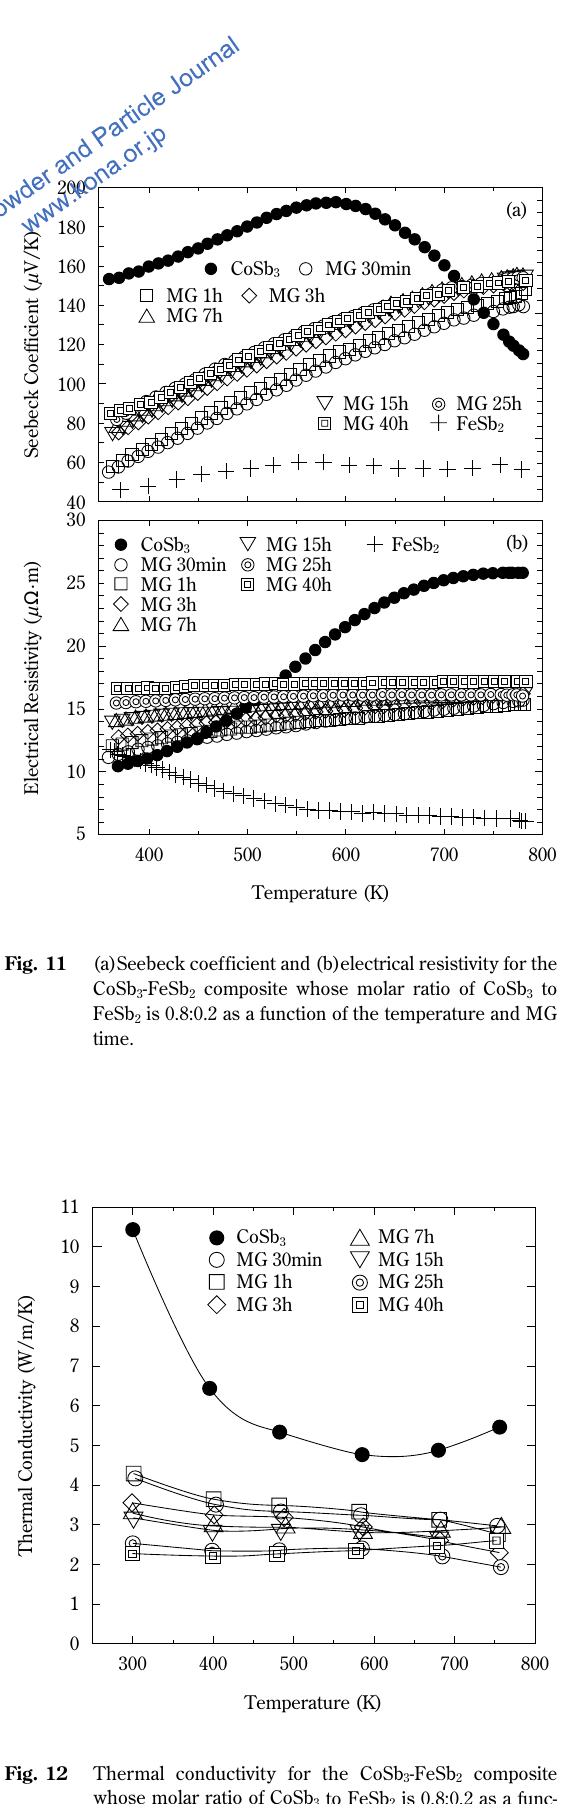
Fig. 12 Thermal conductivity for the CoSb 3 -FeSb 2 composite whose molar ratio of CoSb 3 to FeSb 2 is 0.8:0.2 as a func- tion of the temperature and MG